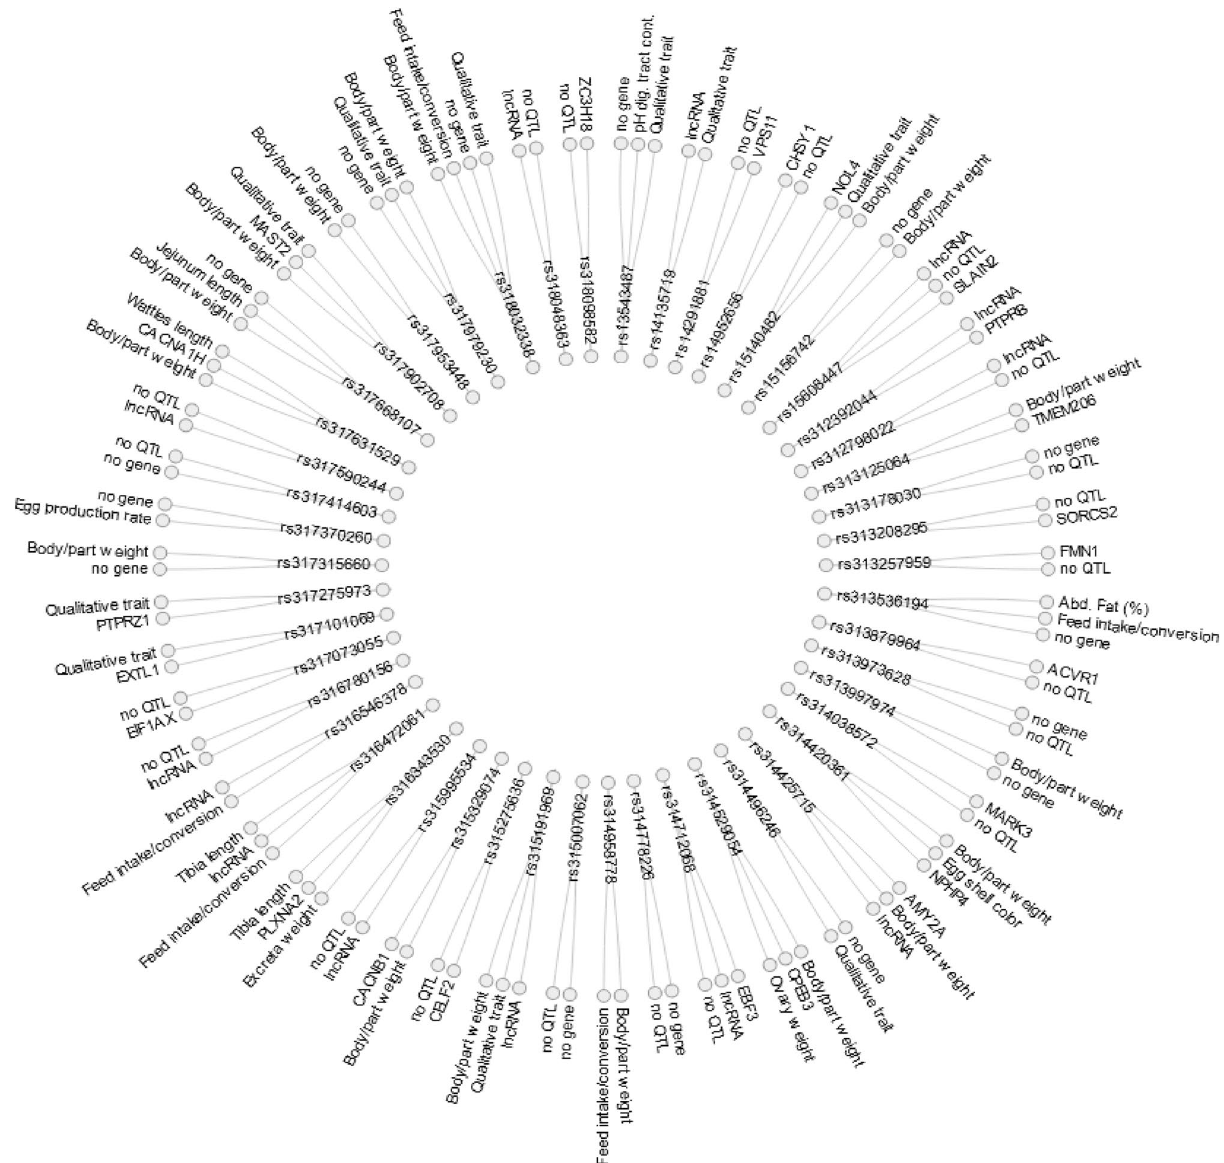
Figure 4. Radial network showing the independent cross-phenotype significant SNPs (with rsids ) and the corresponding positional candidate genes and/or published QTLs in the searched regions. Note that QTLs were grouped according to their trait relevance. Figure was constructed using data.tree and networkD3 R